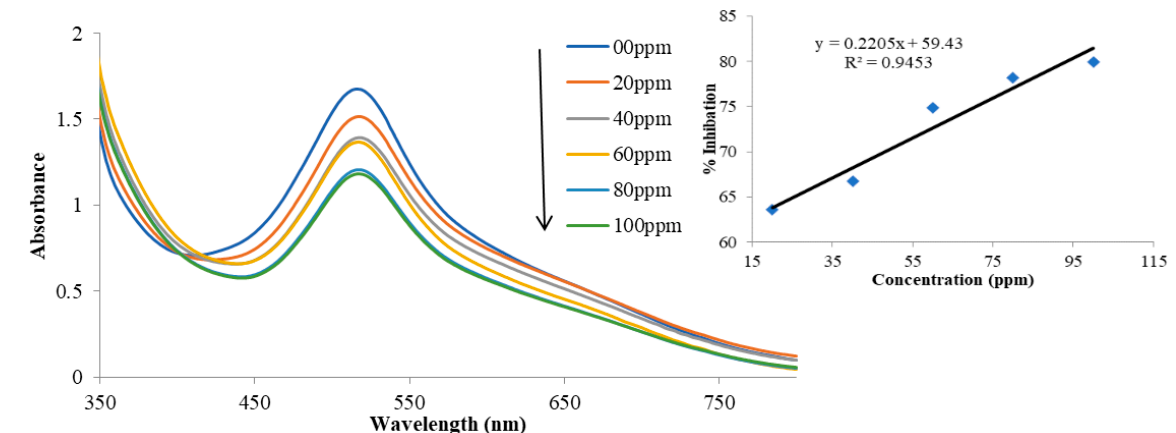
Figure 14. Absorption spectra of blank (DPPH, top) which alters by addition of compound 2 ( left ), graphical representation of % Inhibition versus concentration of compound 2 mixed with DPPH solution ( right ).